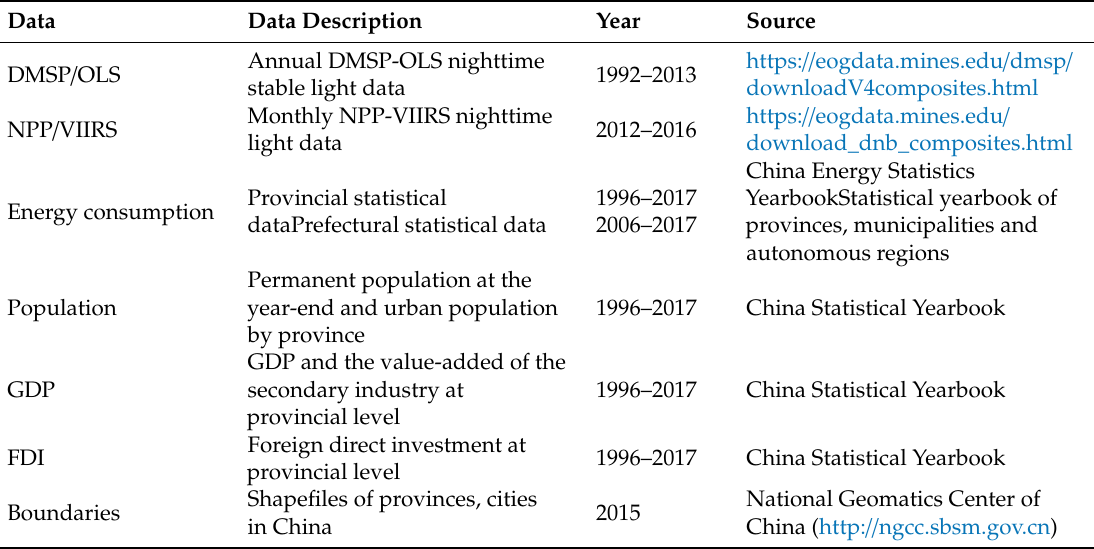
Table 1. Description of the data used in this